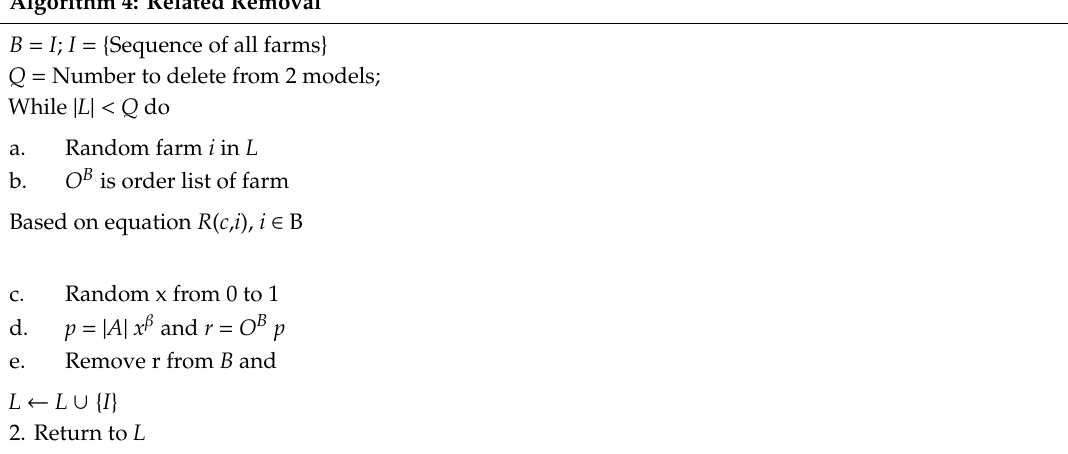
Algorithm 4: Related